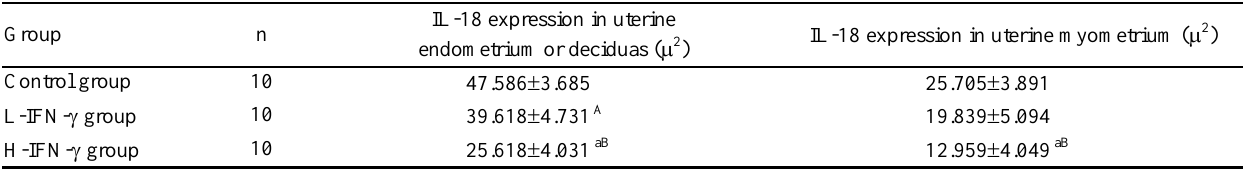
A Compared with the control group (p<0.05). a Compared with the control group (p<0.01). B Compared with the L-IFN-  group